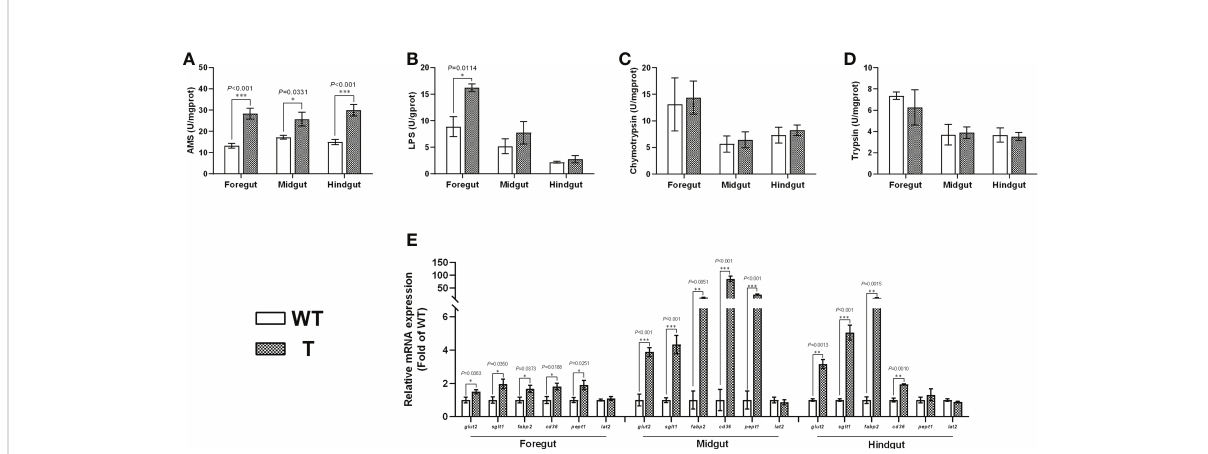
FIGURE 3 Intestinal digestive enzyme activity levels and the gene expression levels of nutrient transport proteins in 4-month-old T and WT common carp. (A-D) Activity levels of a -amylase ( a -AMS), lipase (LPS), chymotrypsin, and trypsin. (E) The gene expression levels of nutrient transport proteins (n = 6). WT, wild-type common carp. T, GH transgenic common carp. * P < 0.05, ** P < 0.01, *** P < 0.001.